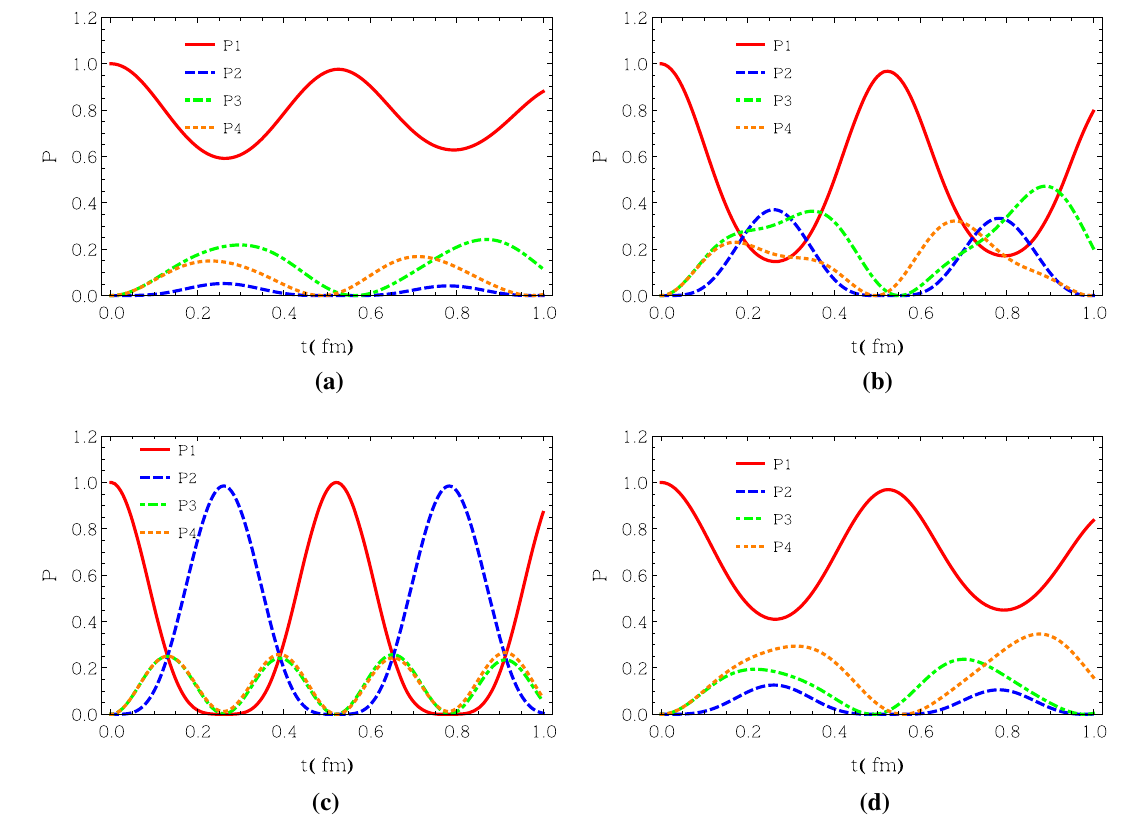
Fig. 1 Survival probability P 1 and spin flipping transition probabilities P 2, P 3, P 4 to other spin states | ψ 2 (cid:3) , | ψ 3 (cid:3) , | ψ 4 (cid:3) for different values of θ as in a θ = 0 . 5, b θ = 0 . 9, c θ = 1 . 6, d θ = 2 . 5 as a function of time in the unit of f m /